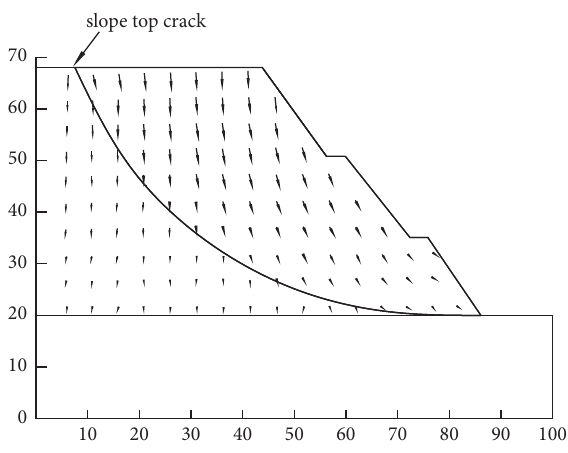
Figure 10: Slope deformation vector diagram (unit: mm).